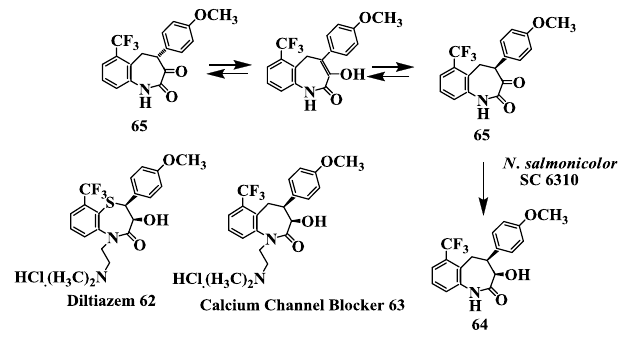
Figure 16. Calcium channel blocker: Preparation of [(3 R - cis )-1,3,4,5-tetrahydro-3-hydroxy-4- (4-methoxyphenyl)-6-(trifluromethyl)-2 H